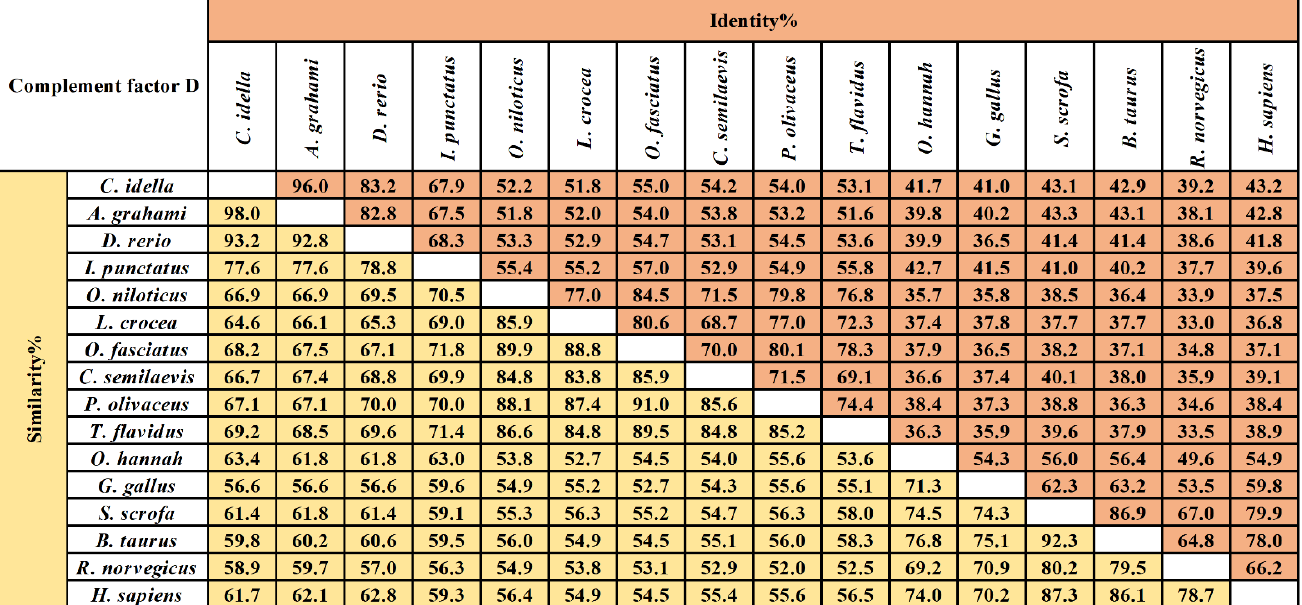
Figure 3. The amino acid sequence identity and similarity of Dfs among different vertebrates. The selected Dfs were from vertebrates including Ctenopharyngodon idella (AHB81535.1 ) , Anabarilius grahami (ROK15838.1 ) , Danio rerio (NP001018368.1 ) , Ictalurus punctatus (AEW10547.1 ) , Oreochromis niloticus (XP003447819.1 ) , Larimichthys crocea (KKF28223.1 ) , Oplegnathus fasciatus (AIZ96981.1 ) , Cynoglossus semilaevis (XP008314450.1 ) , Paralichthys olivaceus (ACV89350.1 ) , Takifugu flavidus (TWW72489.1 ) , Channa striata (SSC14279.1 ) , Gallus gallus (XP_040548688.1 ) , Sus scrofa (XP_013850255.1 ) , Bos taurus (NP001029427.1 ) , Rattus norvegicus (NP001071110.1 ), and Homo sapiens (NP001919.2 ) . The values of similarity and identity are backgrounded in yellow and orange respectively.